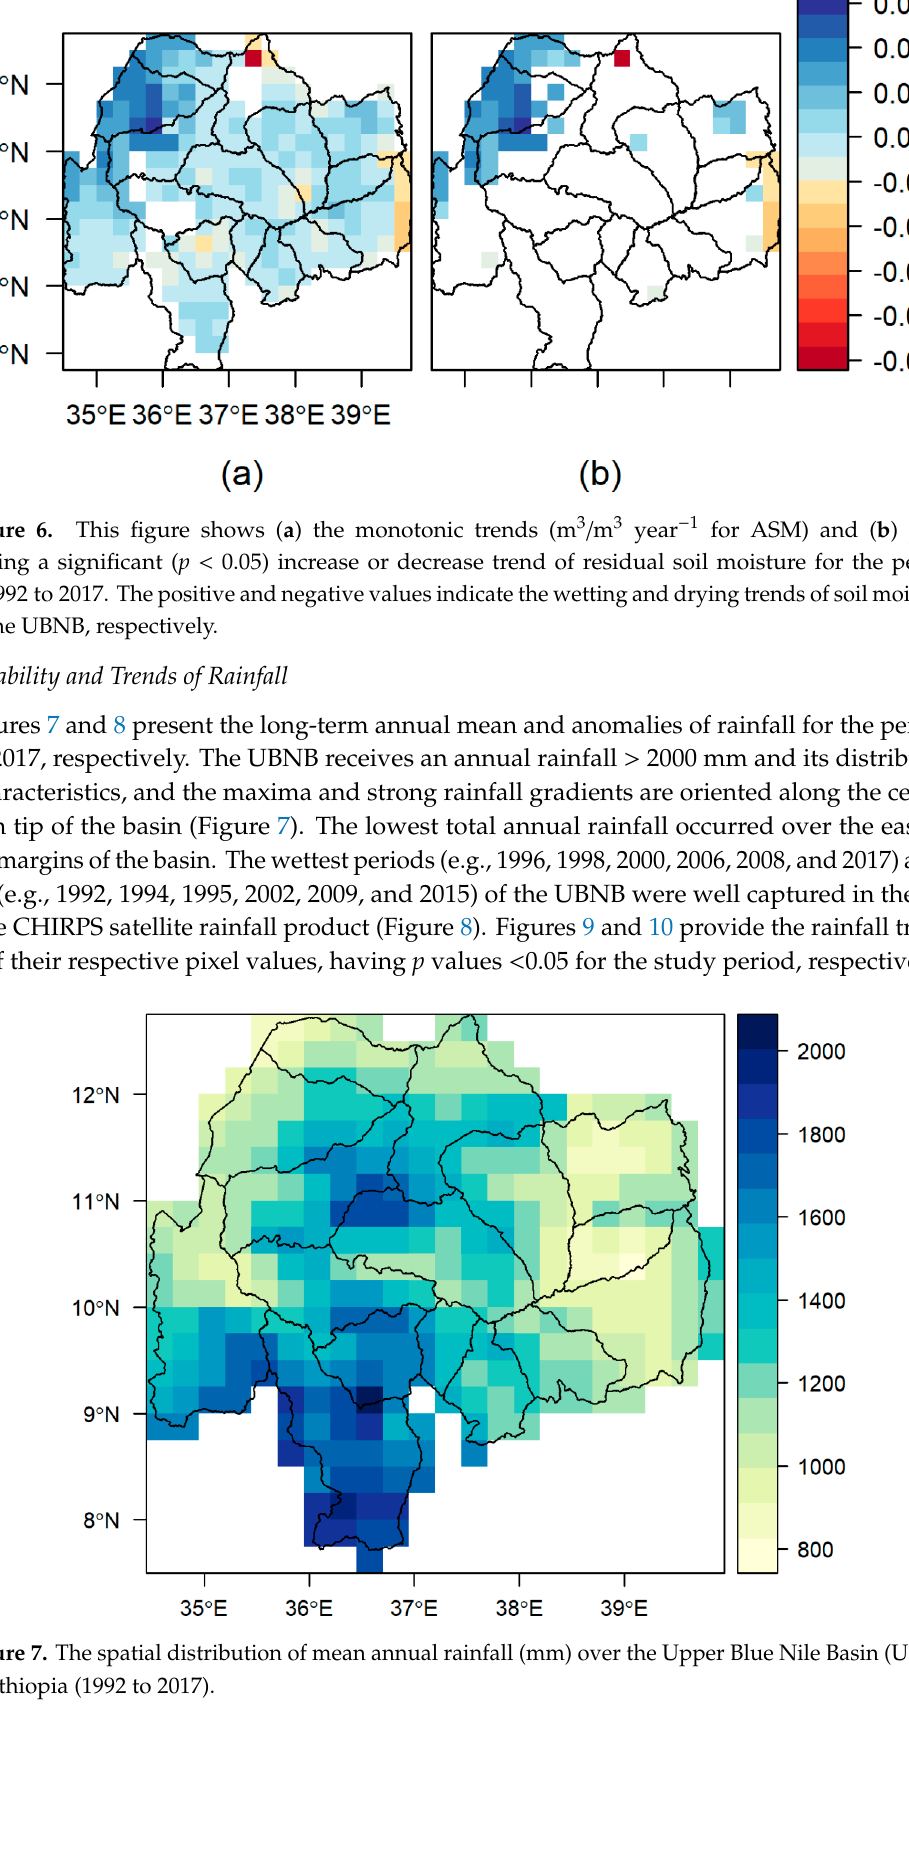
. Figure 8. Standard rainfall anomalies for annual rainfall in the UBNB indicating the magnitude of departure from long-term mean rainfall over a period of 26 years observation (1992–2017). A negative value represents periods of below-normal rains (drought), while positive values indicate above- normal rains (with the possible risk of flood).